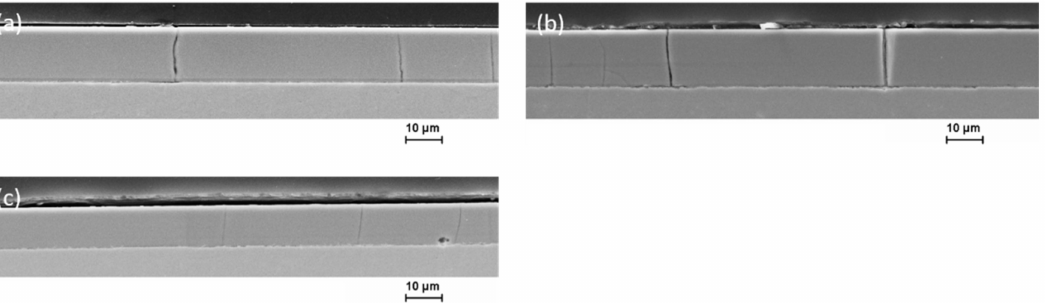
Figure 11. SEM micrographs of cross-sections of electrodeposited Fe-Cr-Ni coatings under stepped DC t on = 5 s, t off = 2 s conditions for three depositions: ( a ) first deposition (2 h of electrolyte use) with several narrow microcracks; ( b ) second deposition (4 h of electrolyte use) with several microcracks; and ( c ) third deposition (6 h of electrolyte use) with a several very narrow microcracks.